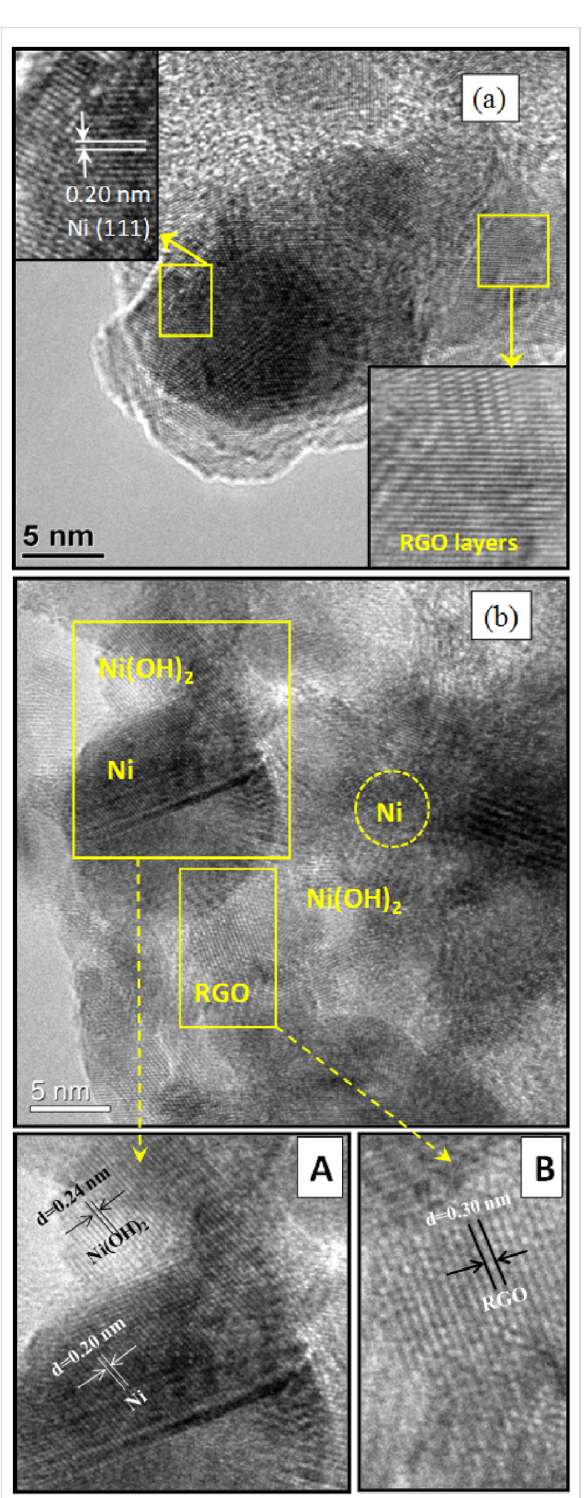
Figure 7: TEM image of (a) Ni/RGO-40 before usage as a catalyst (for comparison, reprinted with permission from [48], copyright 2014 Amer- ican Chemical Society) and (b) recovered catalyst after the first cycle of reaction showing the different domains (marked by yellow enclo- sures). The enlarged views of the marked rectangular areas in (b) are shown in A (Ni species) and B